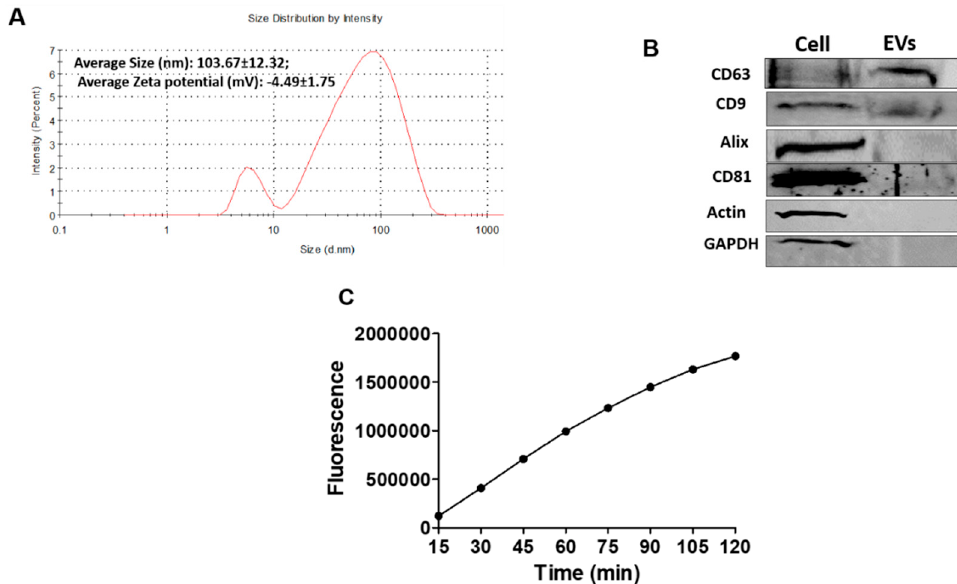
Figure 4. Characterization of extracellular vesicles (EVs) derived from Caski cells. ( A ) Representative plots from Zetasizer showing size distribution and zeta potential of Caski cell-derived EVs. ( B ) Protein obtained from Caski cells and their derived EVs was examined for the expression of EVs markers, CD63, CD9, Alix, and CD81. The housekeeping proteins of cells, actin, and glyceraldehyde 3-phosphate dehydrogenase (GAPDH), were also examined in both cells and their EVs. ( C ) The EVs were characterized for their functional identity using acetylcholine esterase activity.